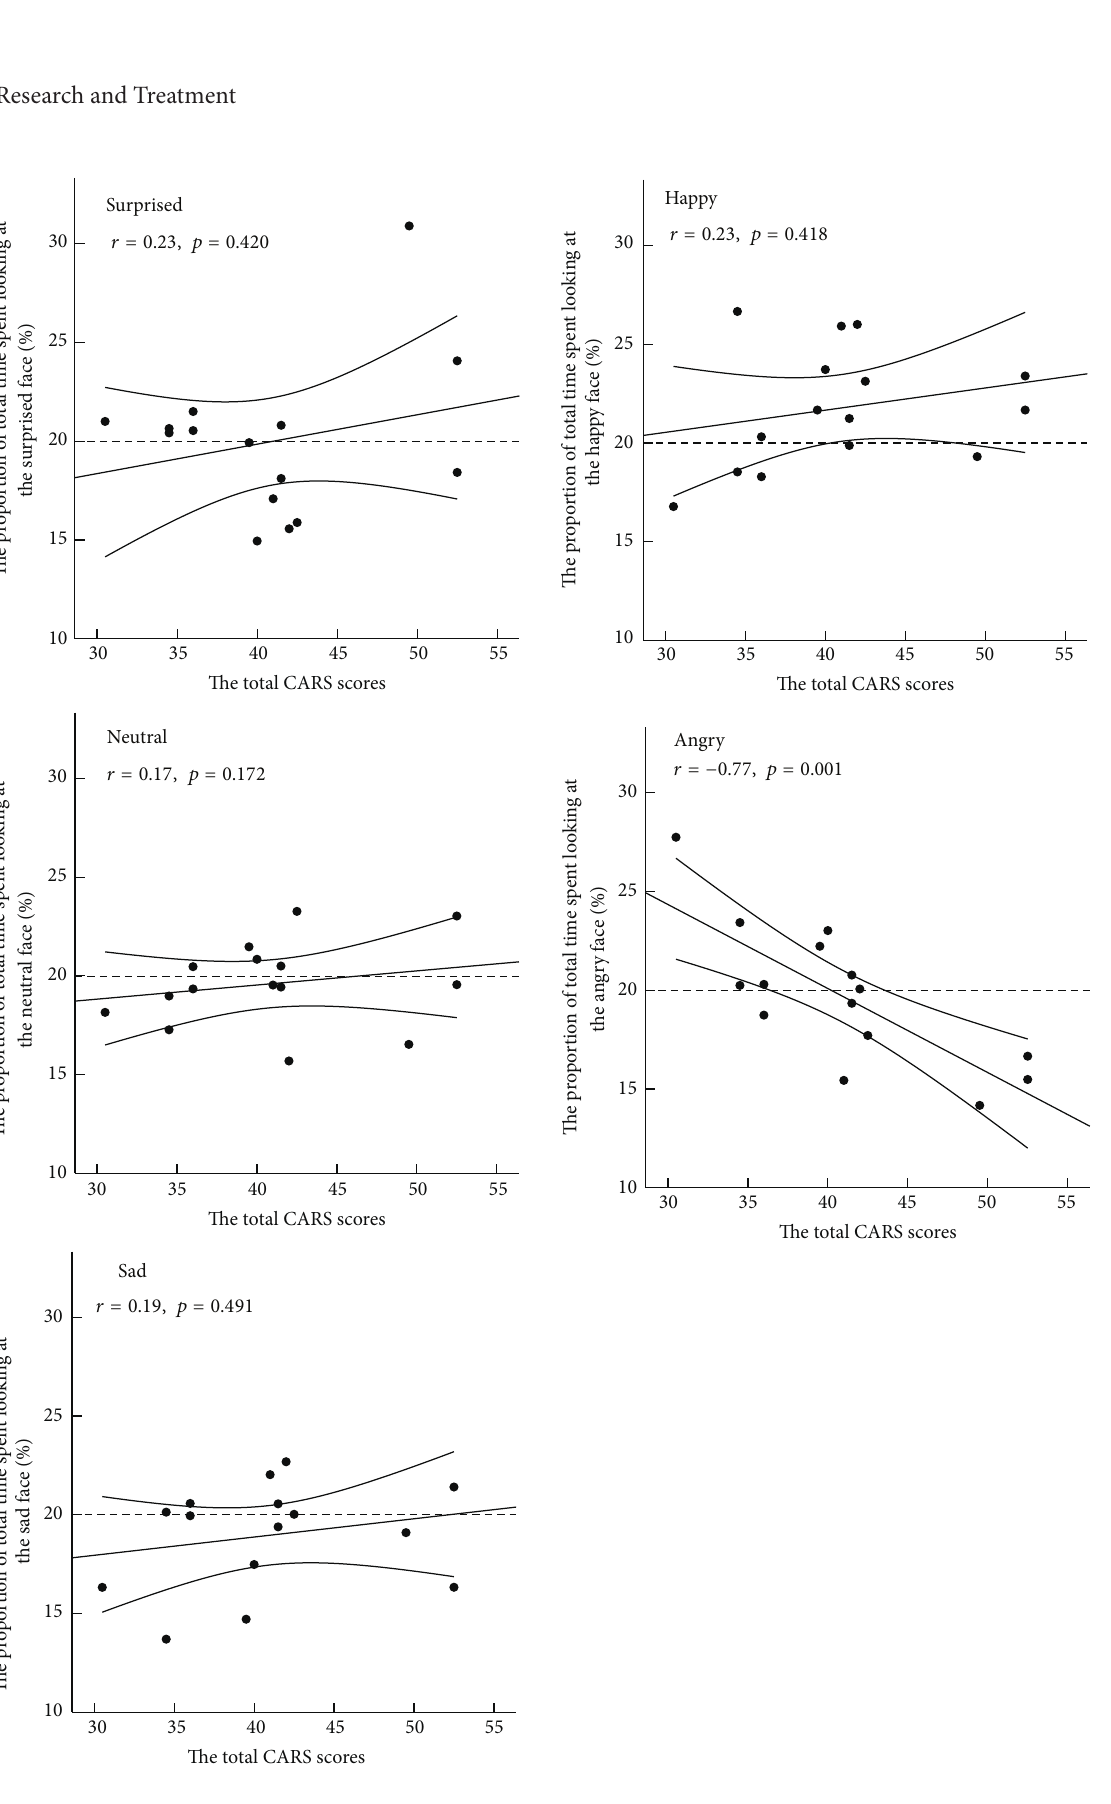
Figure 3: Correlation of the total CARS scores and the proportion of total time spent looking at each facial expression in ASD